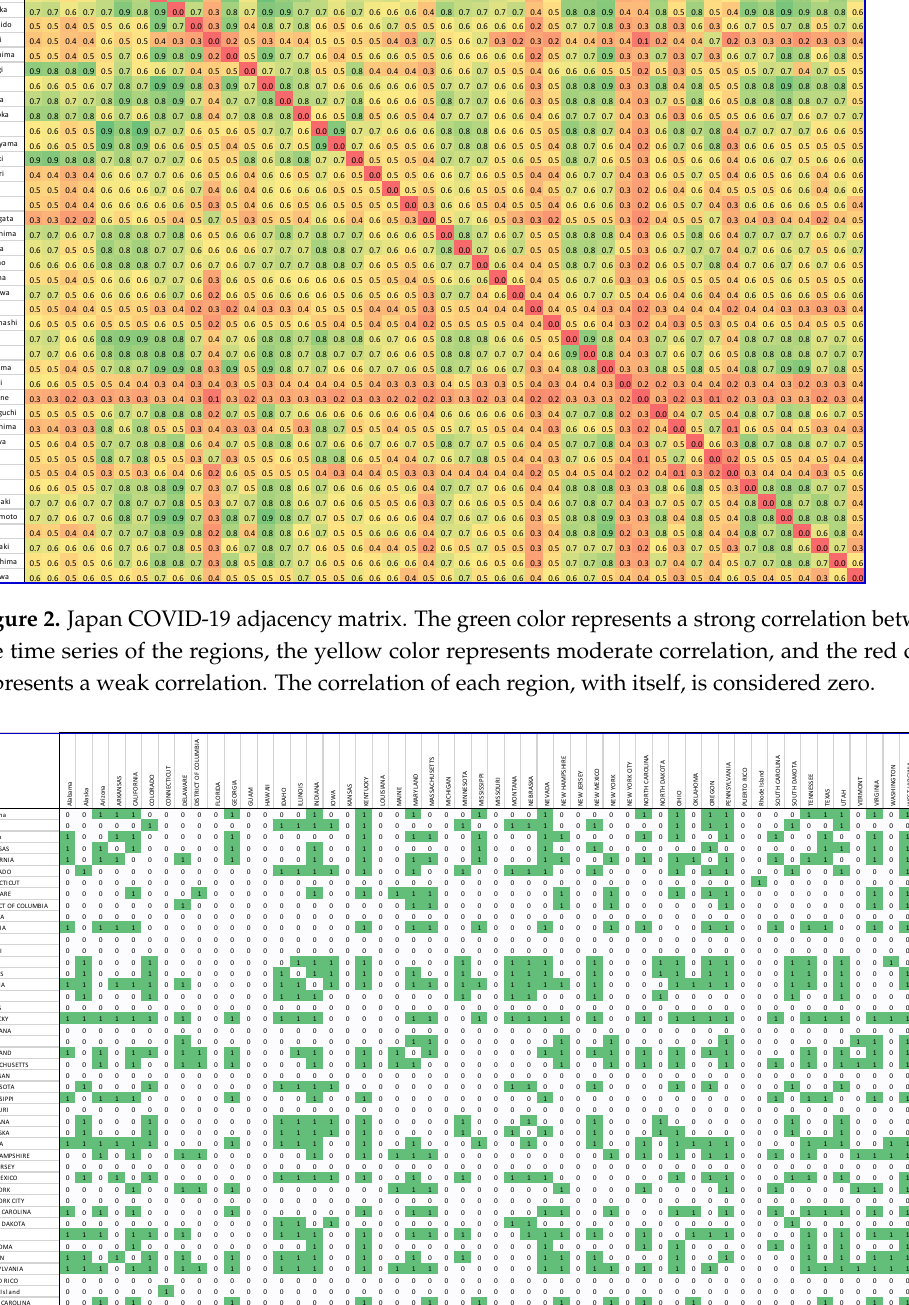
Figure 4. Japan COVID ‐ 19 binary matrix. The green color represents a strong correlation between the different regions. All strong correlations are represented by 1. Table 1. Network measures. Metrics